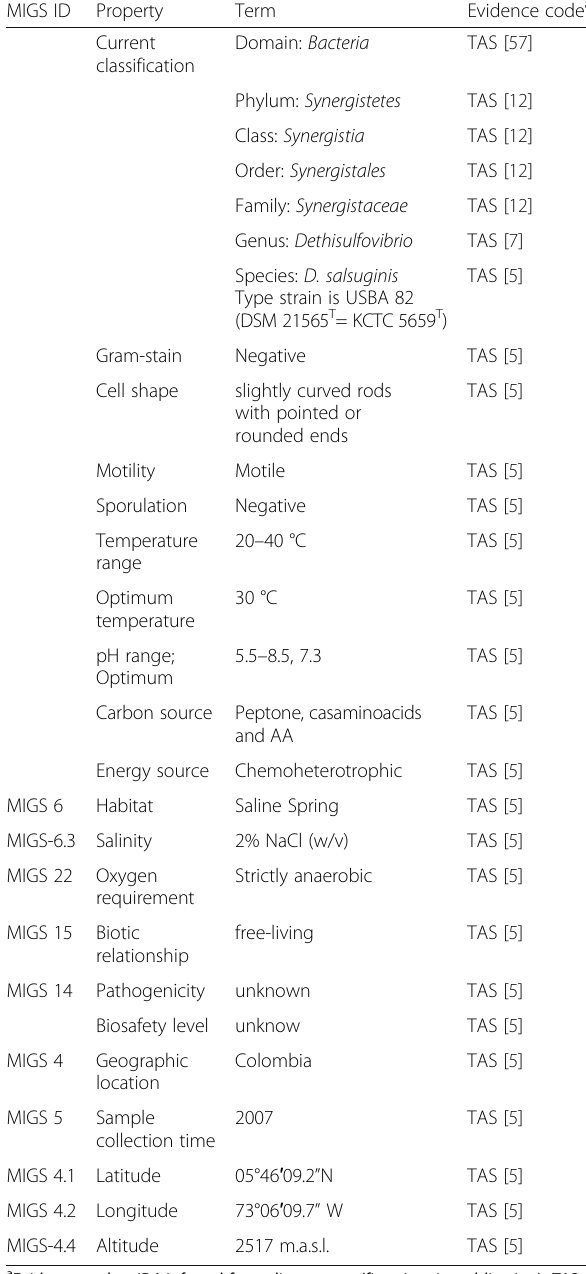
Table 1 Classification and general features of D. salsuginis according to MIGS standards